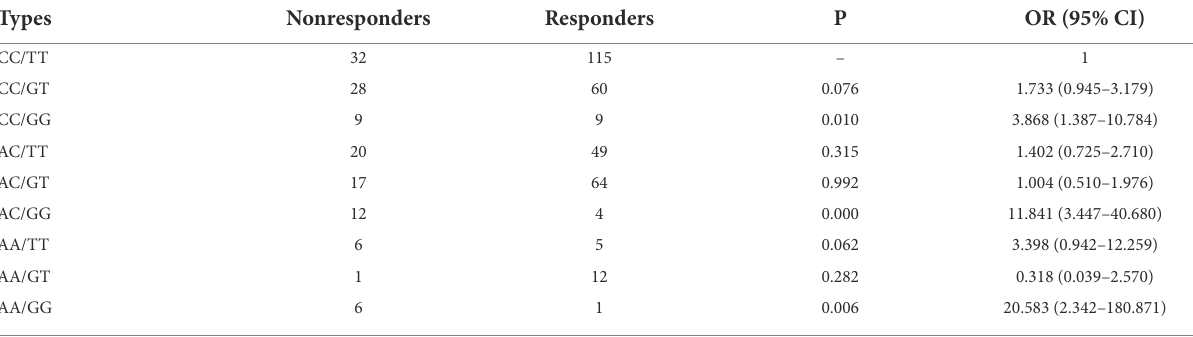
TABLE 5 Joint effects analysis of rs2556375 and rs12477097 for therapeutic response of patients with epilepsy.